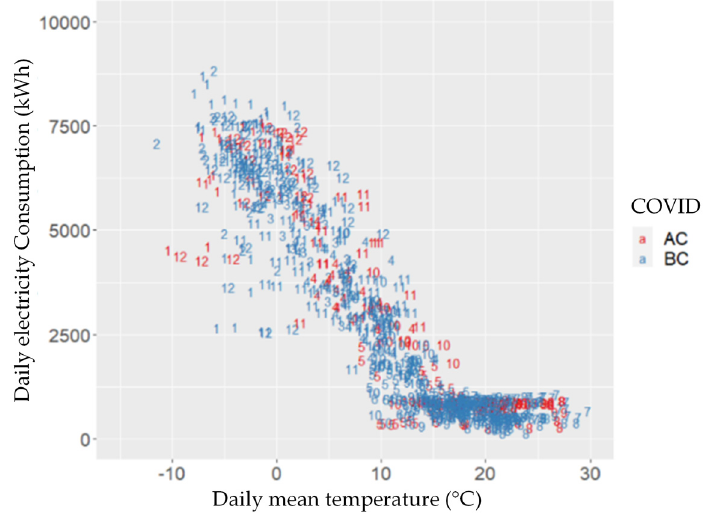
Figure 10. Relationship between daily energy consumption and outdoor temperature at High School B.